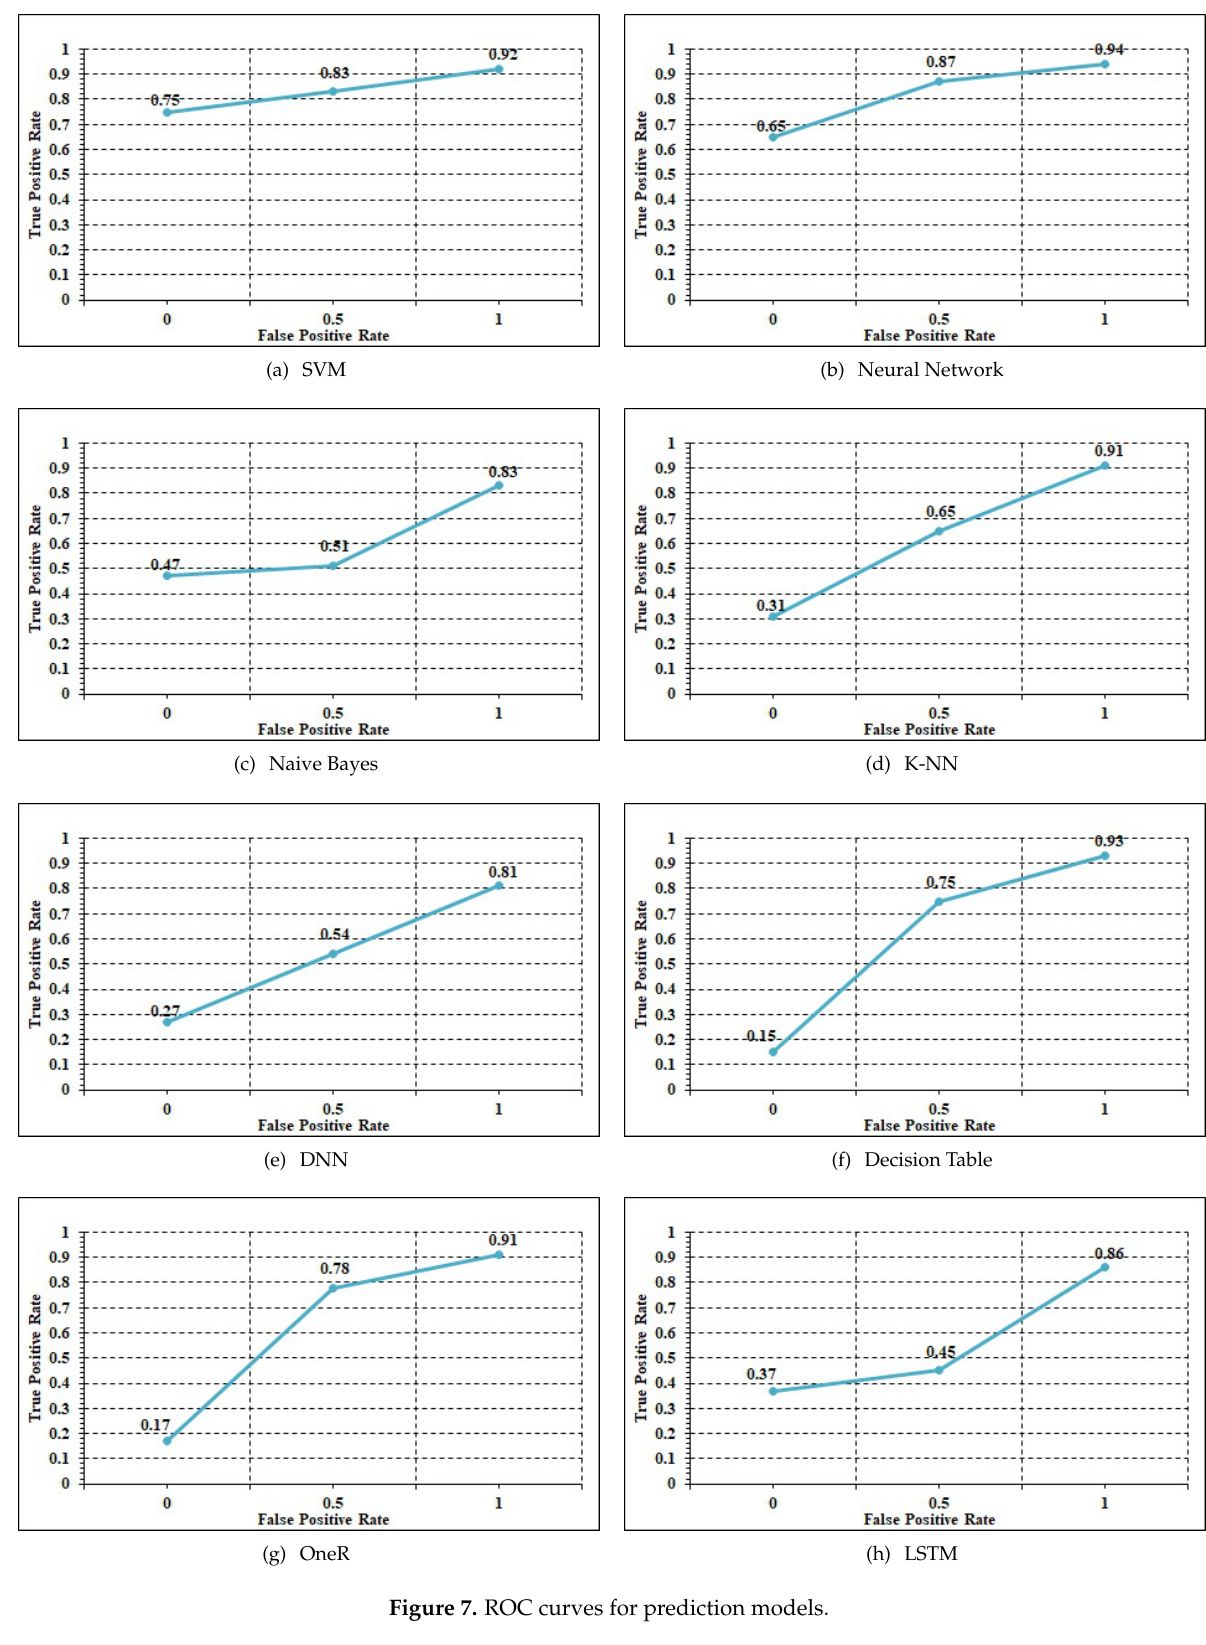
Figure 7. ROC curves for prediction